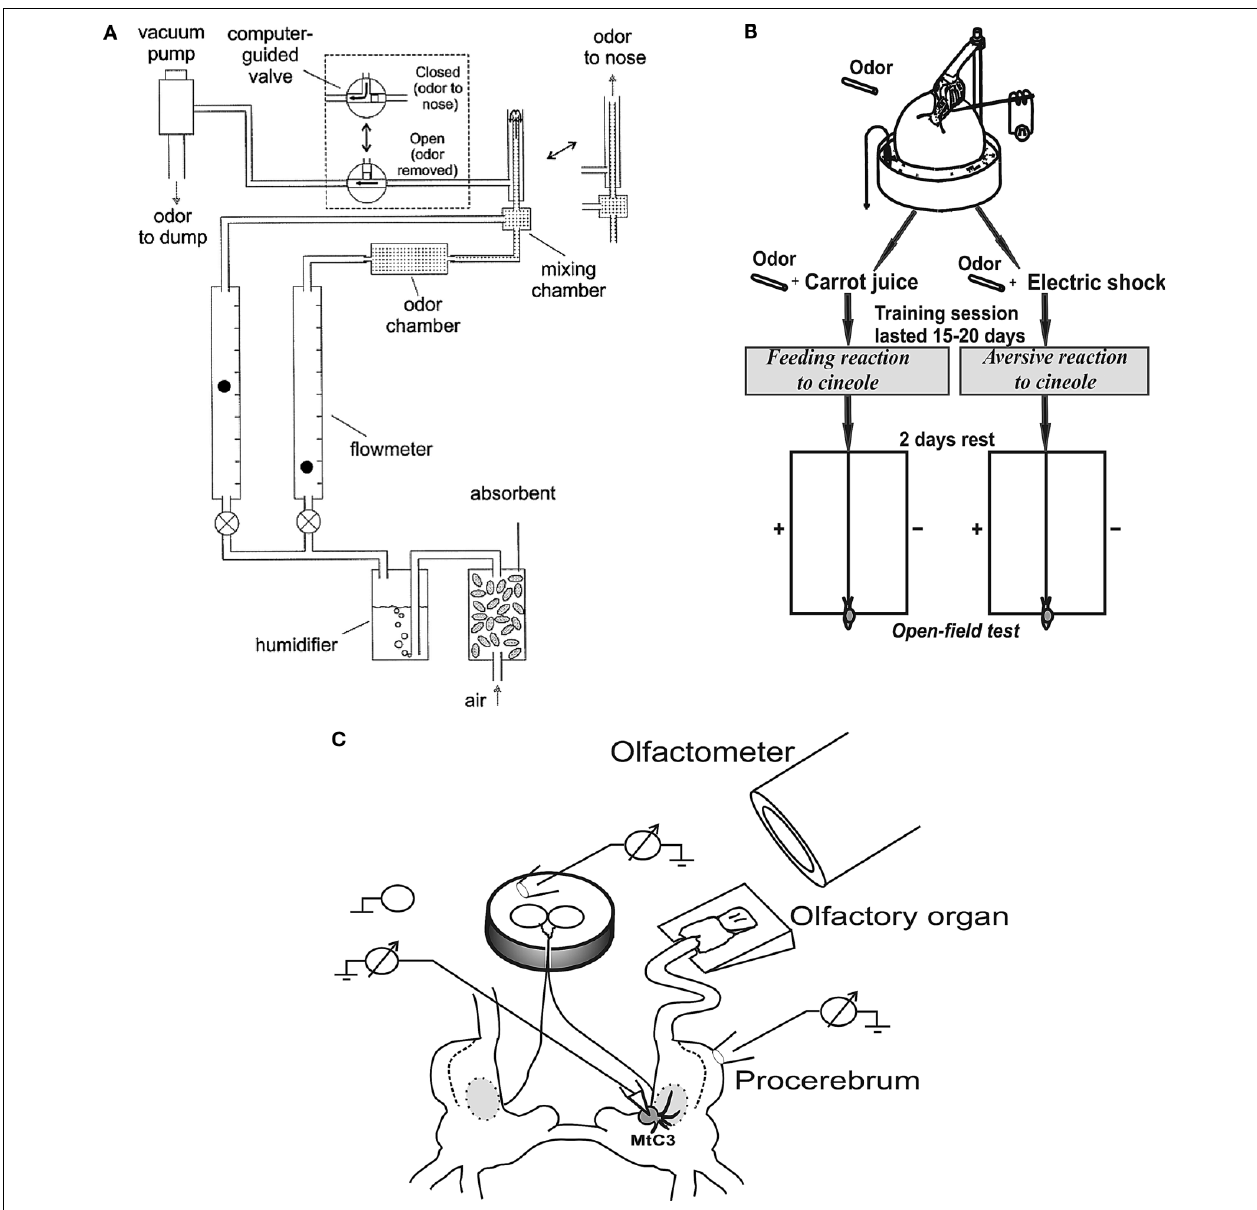
snail is shown in a start position; (C) Scheme of the semi-intact preparation of the CNS with the attached intact olfactory nerve, additional chamber for recording activity of buccal nerves, and the nose positioned on a small